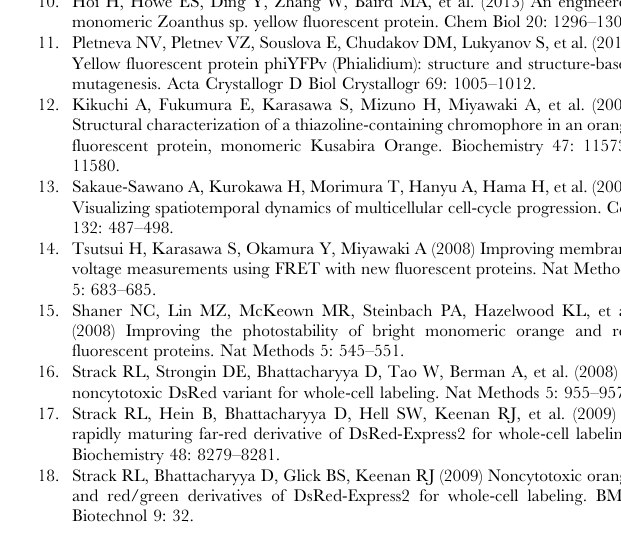
Figure S1 Amino acid alignment of orange fluorescent proteins. The chromophore-forming tri-peptides are highlighted in yellow.